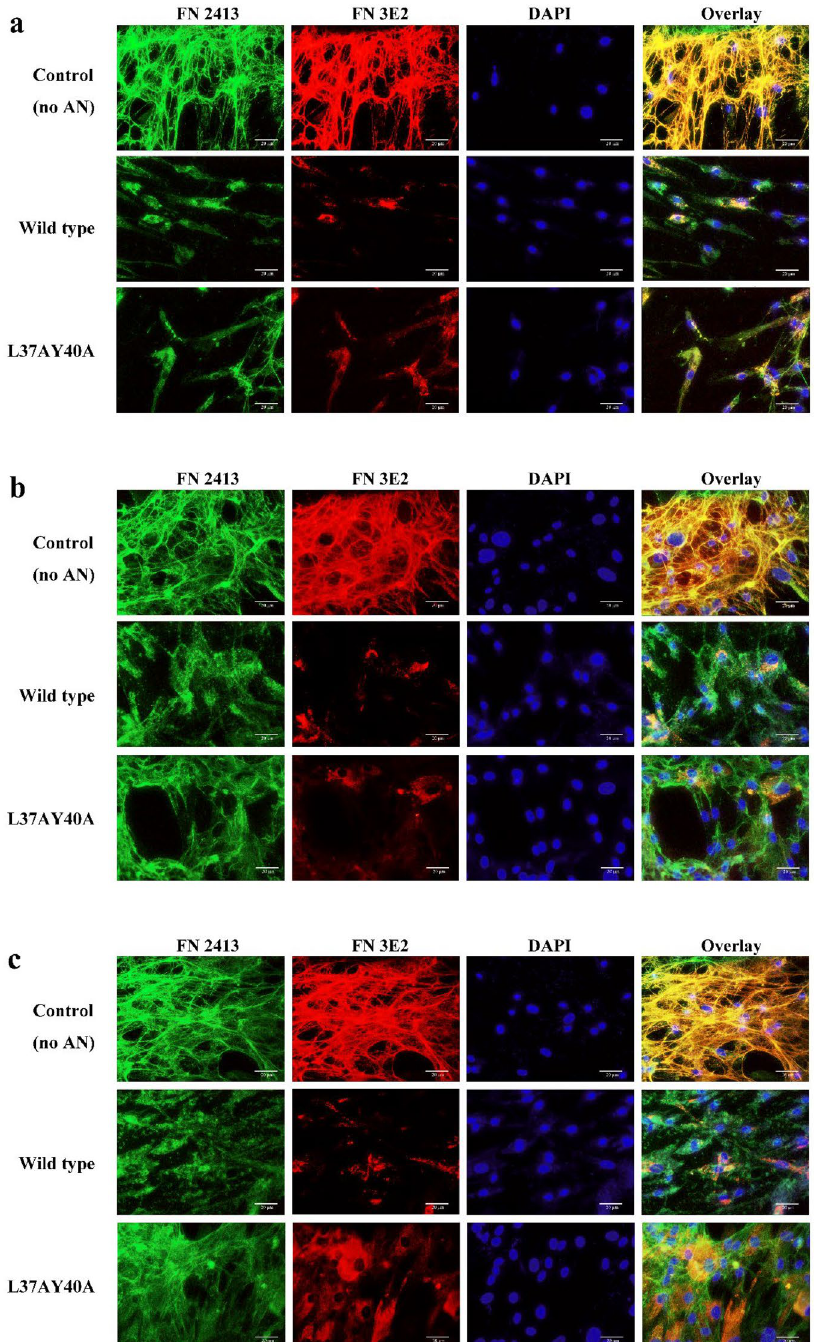
Figure 2. AN influences FN structure in ECM from cells cultured in basal media. Primary HCASMC at an initial density of 2.25 × 10 4 cells per well in 8-well chamber slides were cultured in basal media overnight and then incubated in basal media supplemented with 30 μM AN (wt or L37AY40A) and either 0 ( a ), 10 ( b ) or 100 ( c ) ug mL −1 FN for 24 h. HCASMCs on the slides were then fixed and permeabilized followed by incubation with primary antibodies at 4 °C overnight. Total FN was visualized by anti-FN pAb (2413, 1:500, green channel) and cell-derived FN detected using a mAb that recognizes the EDA epitope (3E2, 1:500, red channel); nuclei were counterstained using DAPI (blue channel). Overlays of images are shown on the right. Scale bars: 20 μm. Pixel intensity plots from three independent experiments are displayed in Supplementary Fig.